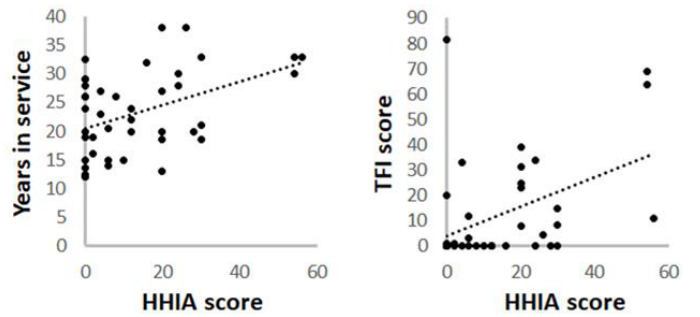
Figure 3. Association of self-perceived hearing handicap with duration of employment and tinnitus. Bivariate regression analysis indicated a positive correlation between HHIA scores and the number of years in service as a firefighter (R 2 = 0.1926, left panel). The strength this correlation increased when controlled for age (R 2 = 0.2225). In addition, the HHIA scores were associated with the TFI scores (R 2 = 0.1975, right panel).